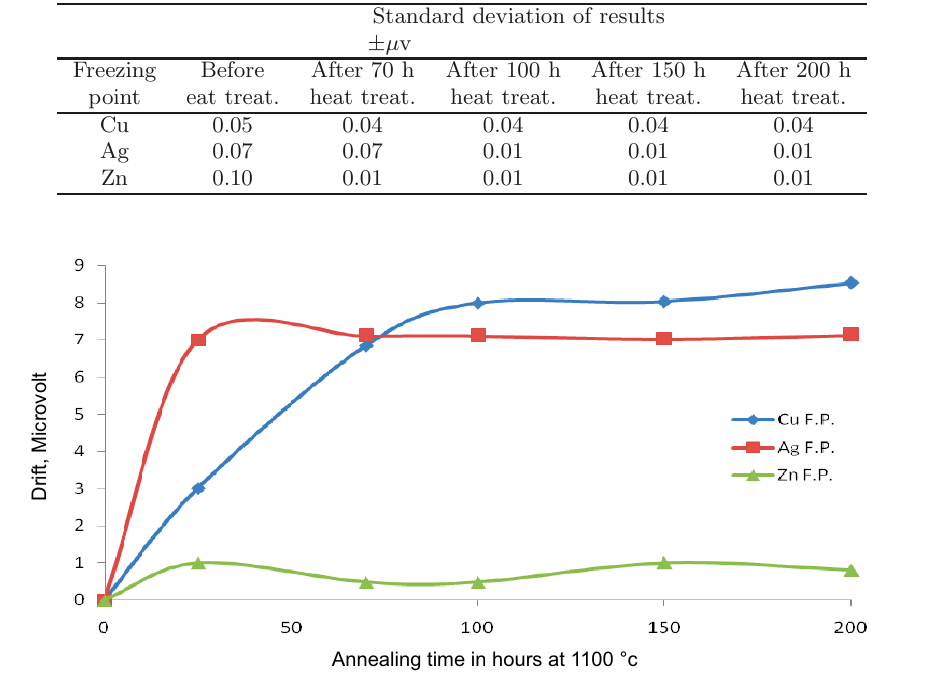
Fig. 2. The Pt/Pd thermocouple stability at Zn, Ag and Cu freezing points after different heat treatments.